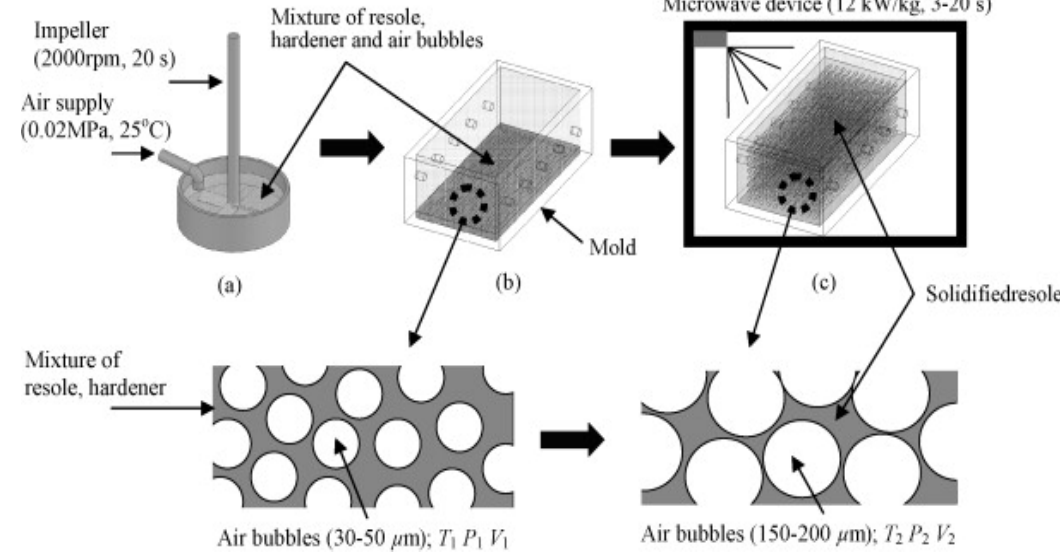
Figure 5. ( a ). Microwave foaming method: ( a ) mixing resole and hardener with air bubbles embedded, ( b ) injection to mold, and ( c ) microwave foaming. Reprinted with permission from the authors of [15]. Copyright © (2008) Elsevier.